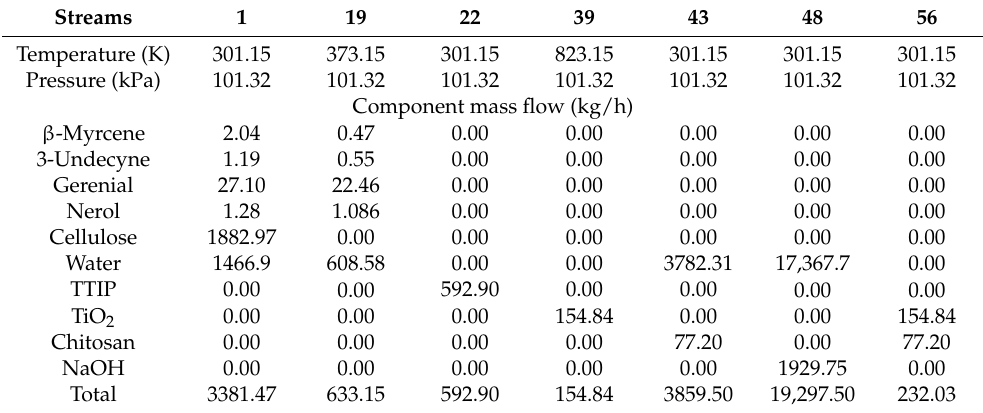
Figure 4. Process flowsheet of large-scale production of chitosan microbeads modified with TiO 2 nanoparticles via a green chemistry method: ( a ) Lemongrass oil extraction ( b ) TiO 2 nanoparticles synthesis; ( c ) chitosan microbeads production. Table 2. Main process streams for Chitosan microbeads modified with TiO 2 nanoparticles.